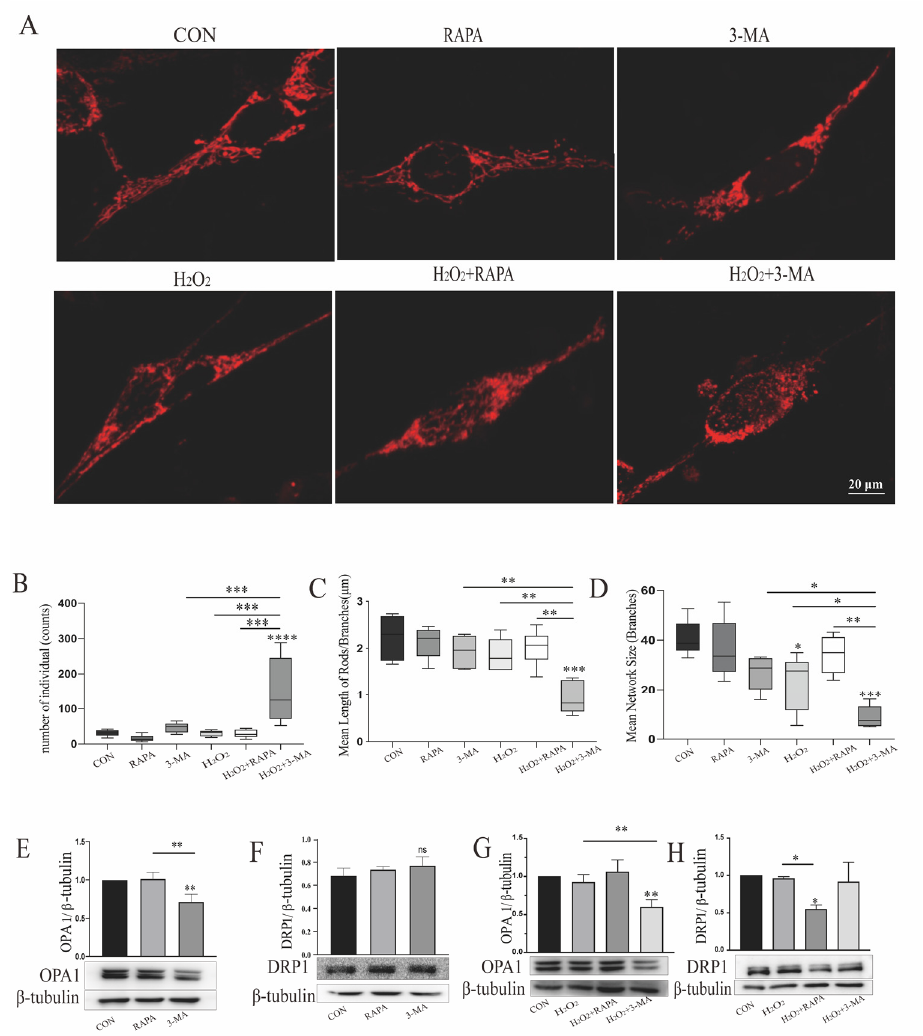
Figure 2. Regulation of autophagy can impact the mitochondrial morphology of MGCs under oxidative stress. ( A ) Fluorescence of mitochondrion-targeted DsRed was used to detect mitochondrial morphology. r-MCs treated with 3-MA under oxidative stress showed fragmented mitochondria. Scale bar: 20 μ m. ( B – D ) MiNA was used to analyze the related indices of the mitochondrial network structure. Data are shown as means ± SEMs ( n = 5–7 per group; * p < 0.05, ** p < 0.01, *** p < 0.001 and **** p < 0.0001). ( E – H ) Quantitative analysis of OPA1 and DRP1 was performed. Data are shown as means ± SEMs ( n = 3 per group; * p < 0.05 and ** p < 0.01). RAPA, rapamycin; 3-MA, 3-methyladenine; OPA1, optic atrophy gene 1; DRP1, dynamin-related protein 1.